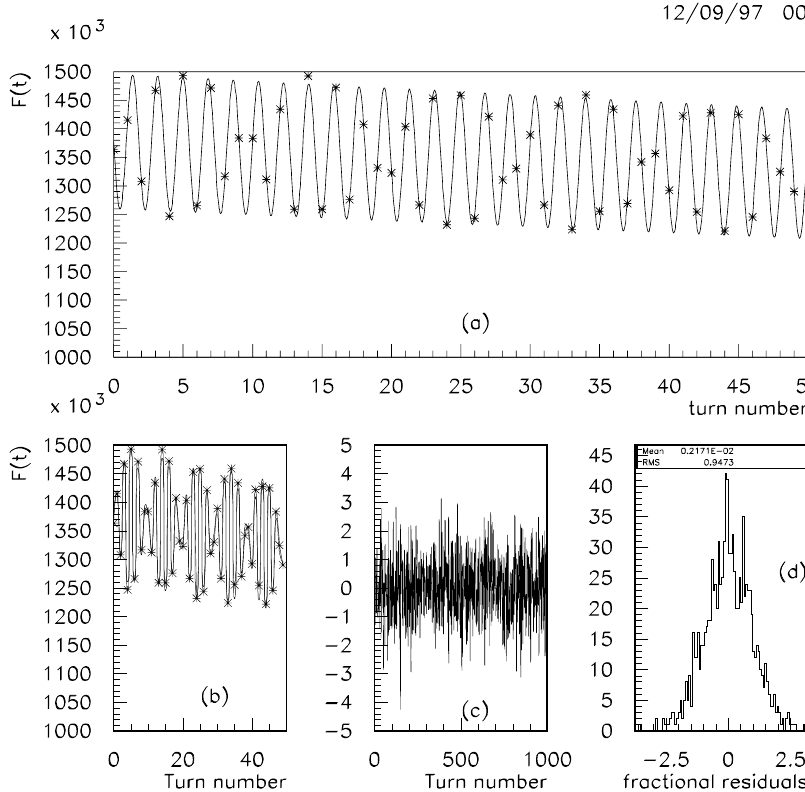
FIG. 58. (a) Energy detected in the calorimeter during the first 50 turns in a 50 GeV muon storage ring (points). An average polarization value of ˆ P (cid:1) 2 0.26 is assumed and a fractional fluctuation of 5 3 10 2 3 per point. The curve is the result of a MINUIT fit to the expected functional form. (b) The same fit, with the function being plotted only at integer turn values. A beat is evident. (c) Pulls as a function of turn number. (d) Histogram of pulls. A pull is defined by (measured value-fitted value) (cid:1) (error in